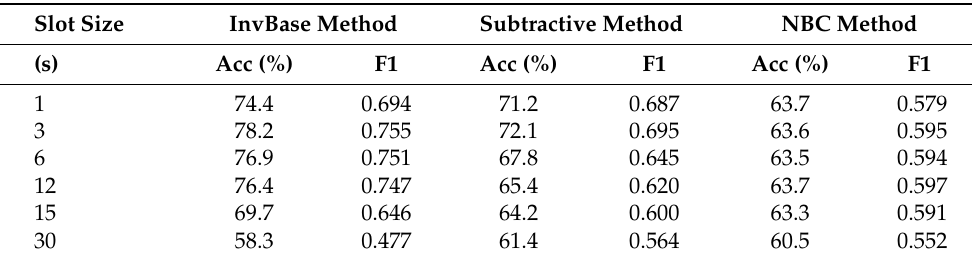
Table 4. Arousal classification accuracies and F1 scores of InvBase, subtractive, and NBC methods using kNN for various slot sizes.